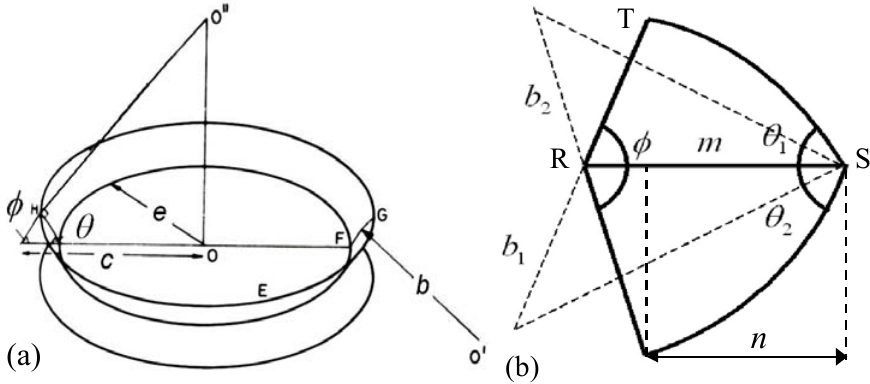
Figure 6. (a) Toroid formation. (b) Toroid